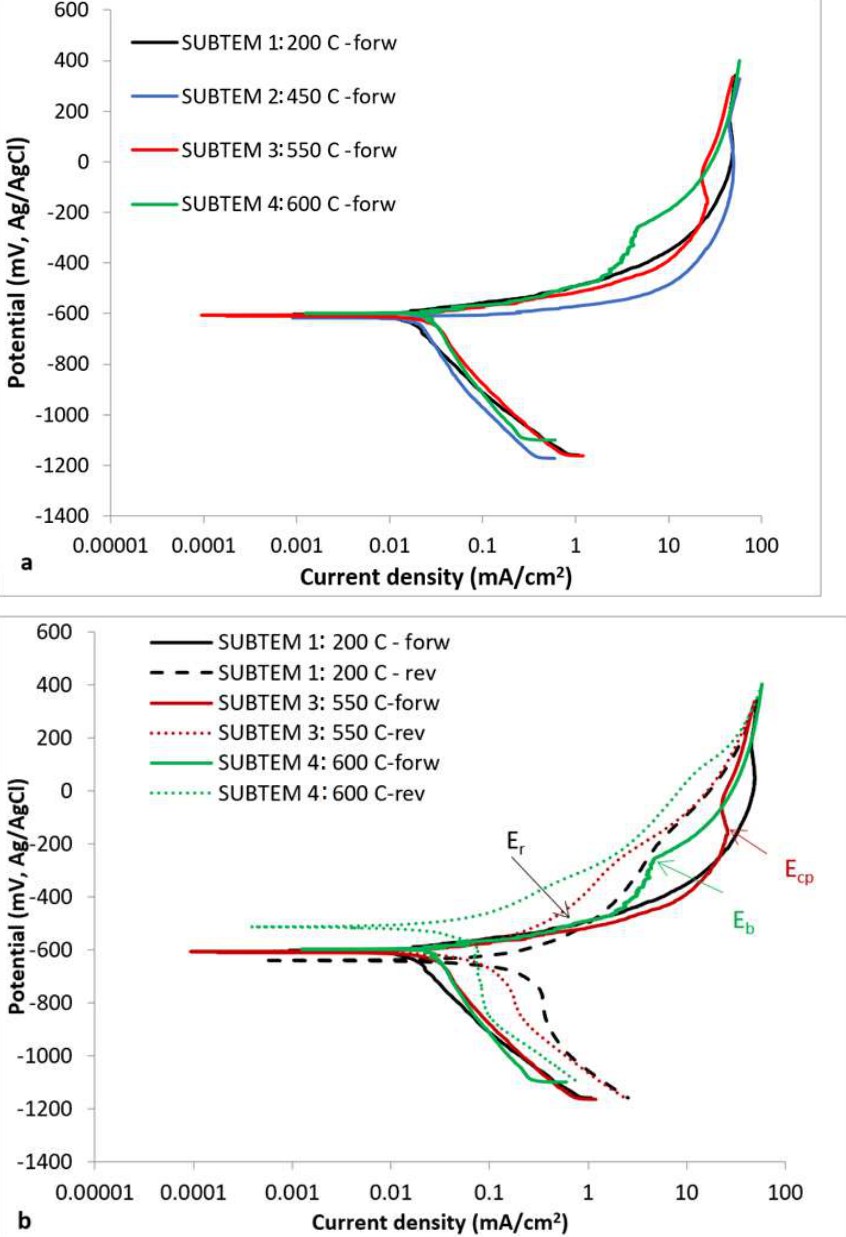
Figure 11. Effect of substrate temperature on the cyclic polarization behavior of nickel aluminide coatings. ( a ) Forward polarization curves; ( b ) cyclic (forward and reverse) polarization curves (3.5% NaCl, 25 °C). Table 5. Electrochemical values of the coatings immersed in 3.5% NaCl at 25 °C: Effect of substrate temperature.